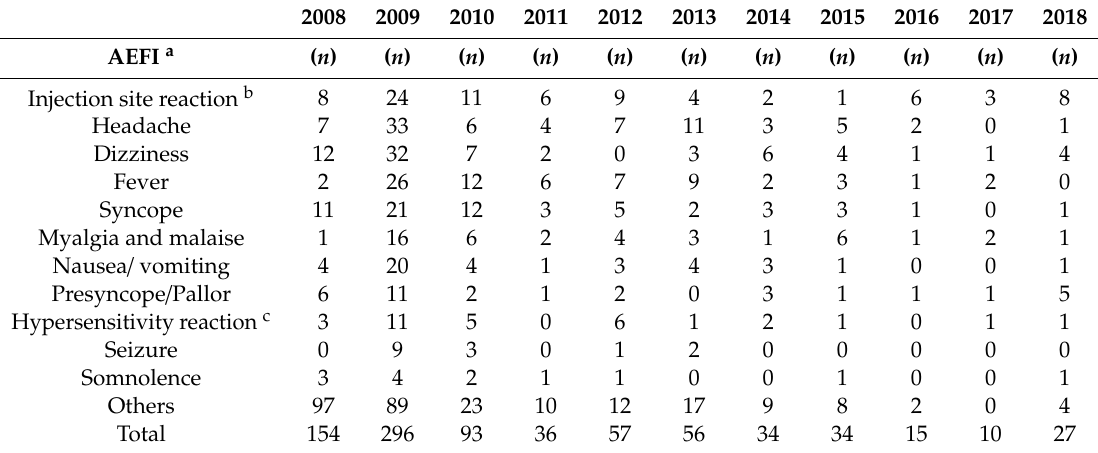
Table 2. Distribution and frequency of reactions listed in AEFI